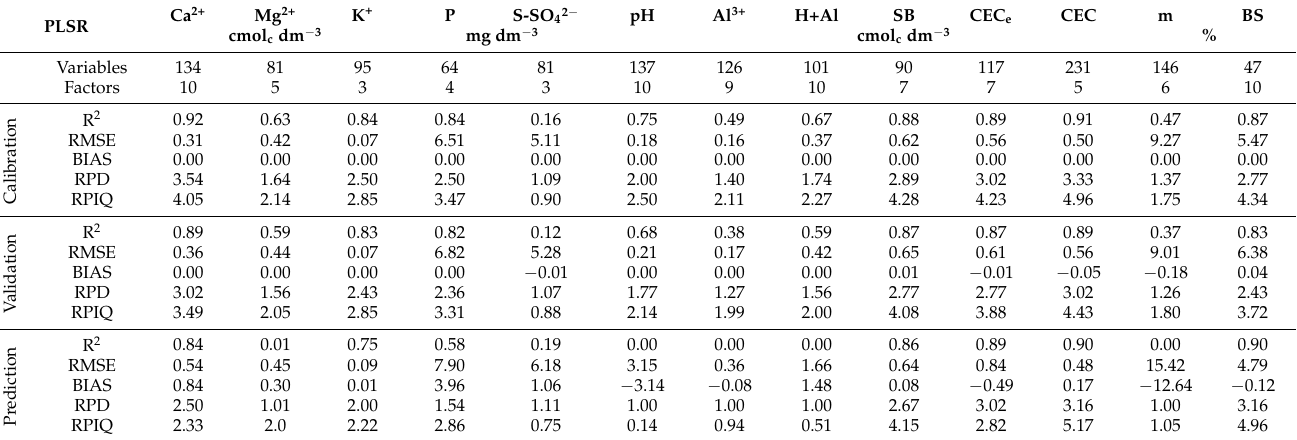
Table 6. Statistical parameters of the PLSR models developed from the fourth soil assessment (with iPLS